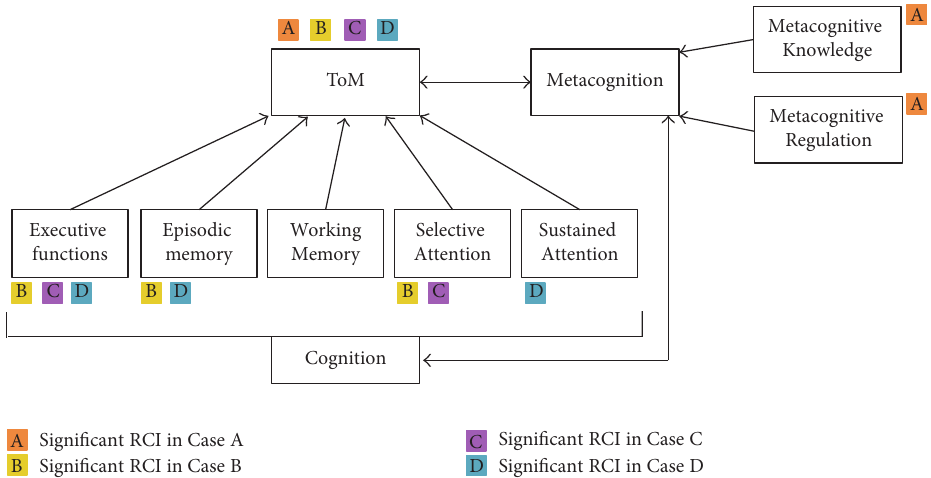
Figure 6: Possible targets leading to ToM improvement. The colors indicate a significant improvement following CRT. In this figure, executive functions include reasoning, cognitive flexibility, inhibition, and planning/organization. Episodic memory and working memory include visual and verbal modalities. Selective attention includes omissions and commissions. Sustained attention includes the change in reaction